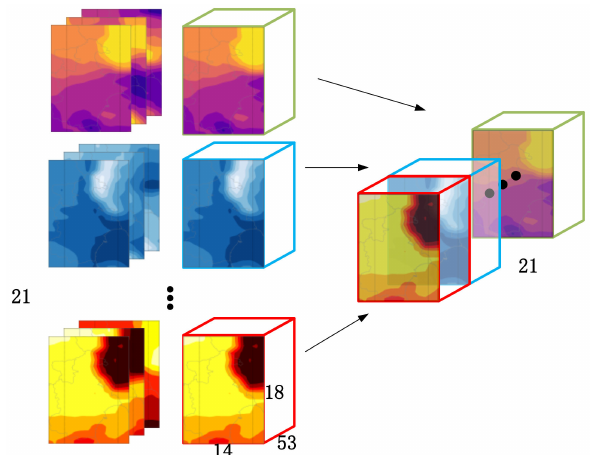
Figure 1. Visualization of model forecast data. Each two-dimensional (2D) heat map represents the distribution of a single weather element at a single time. For each weather element, all of the correspondingheatmapsinthefirstcolumnareconcatenatedthroughtimetoformthethree-dimensional (3D) tensor in the second column. Di ff erent color tensors represent di ff erent weather elements. Twenty-one 3D tensors correspond to 21 types of weather elements. The 3D tensors are concatenated to obtain the four-dimensional (4D) tensor on the right side of Figure 1. Each four-dimensional tensor is a sample in the experiment.